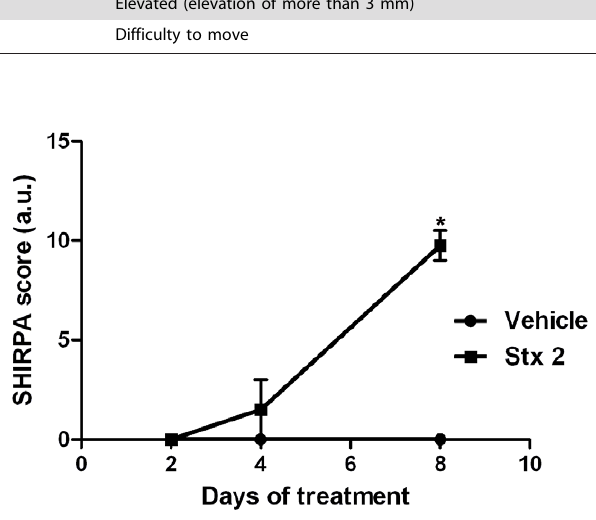
Figure 1. Behavioral motor test. Plotting of SHIRPA scores to standardize results of four motor behavioral tests (spontaneous motor activity, gait, pelvic elevation and hind limb activity). Arbitrary units (a.u.) are the mean summation of the four independent tests for each day and treatment (vehicle or Stx2). Normal behavior=0; abnormal behavior=1. The vehicle-treated group (vehicle) shows no abnormal behavior while the Stx2-treated group (Stx2) shows significant abnormal behavior (*) on day 8 of toxin treatment (p ,